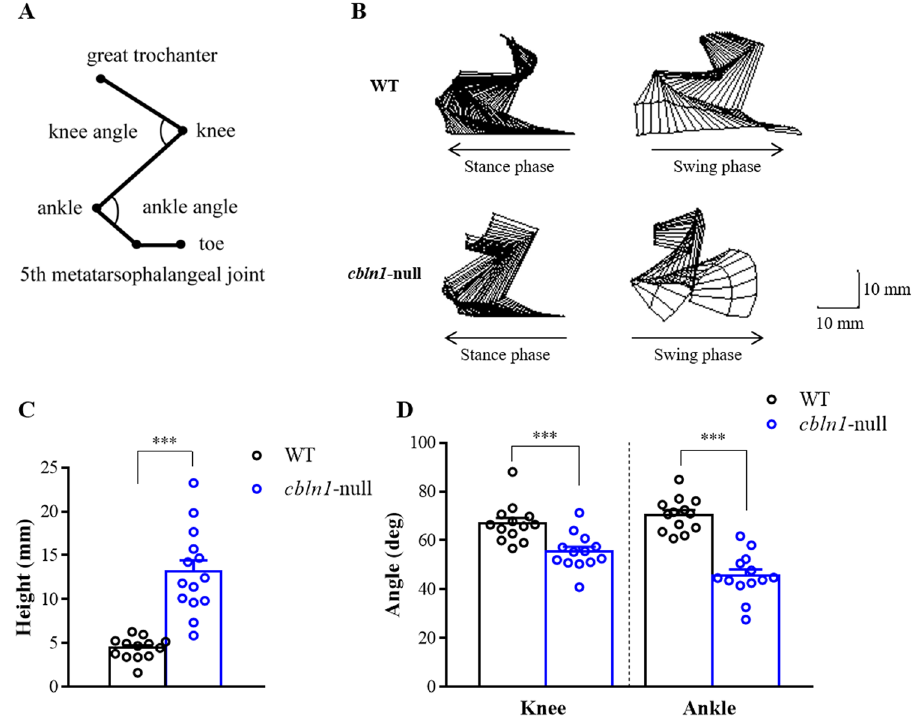
Figure 2. Kinematics of maximal toe height during the step cycle. ( A ) Positions of the reflective markers. Reflective markers were placed on the following anatomical landmarks: great trochanter, knee, ankle, 5th metatarsophalangeal (MTP) joint, and a toe. ( B ) Typical examples of stick figure representations of stance and swing phases for a wild-type (WT) and a cbln1 -null mouse. Scale bar indicates 10 mm. ( C ) Maximal toe heights in wild-type and cbln1 -null mice. ( D ) Joint angles at maximal toe heights. *** p <